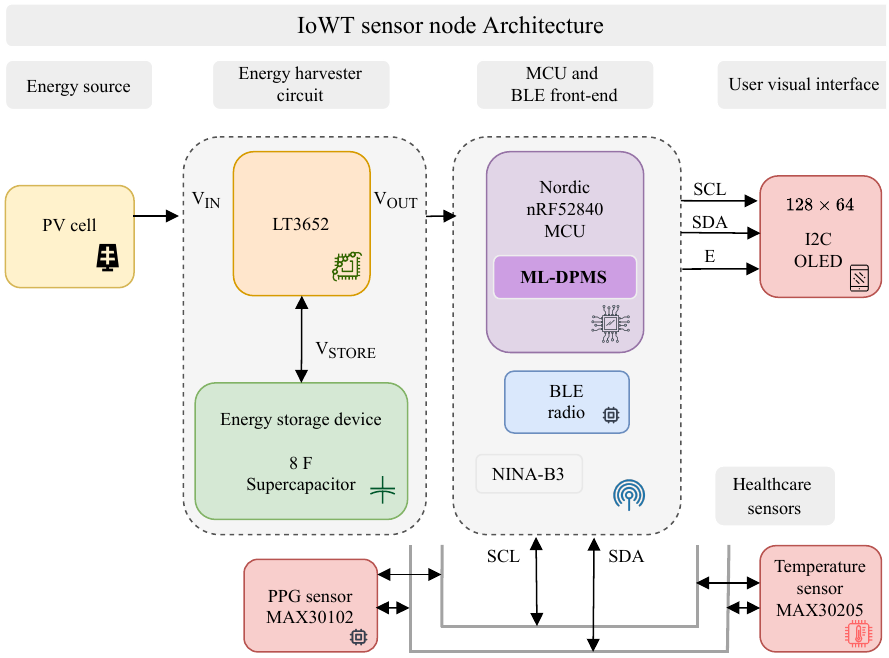
Figure 2. Schematic diagram of the proposed PPG-based sensing